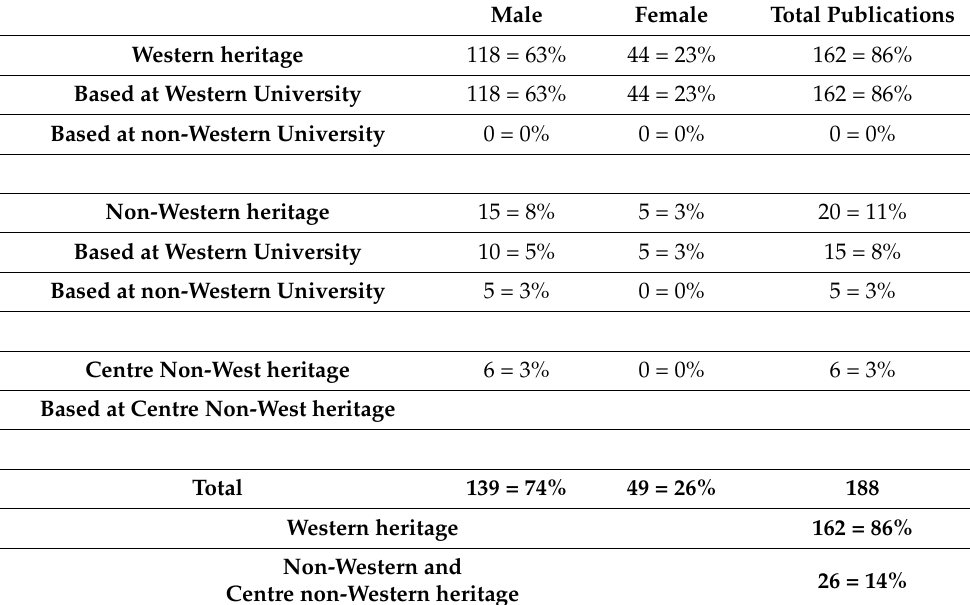
Table A5. Security